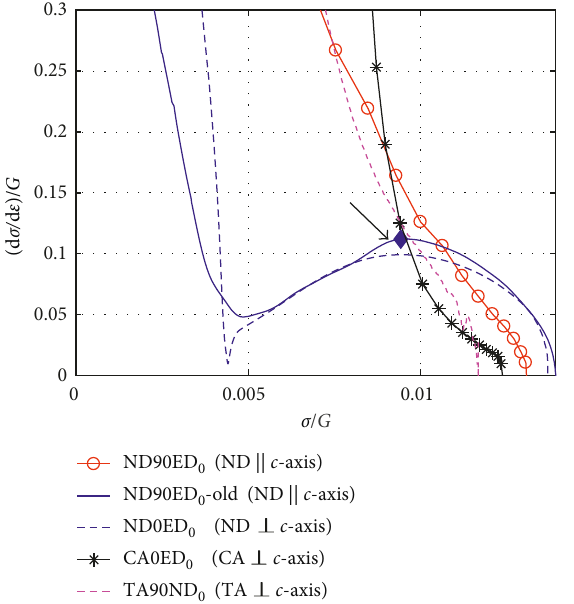
Figure 3: Normalized strain-hardening responses of pure mag- nesium at room temperature under different mechanical tests including PSC (ND90ED 0 and ND0ED 0 ), simple compression (CA0ED 0 and CA0ND 0 ), and uniaxial tensile (TA90ND 0 ).